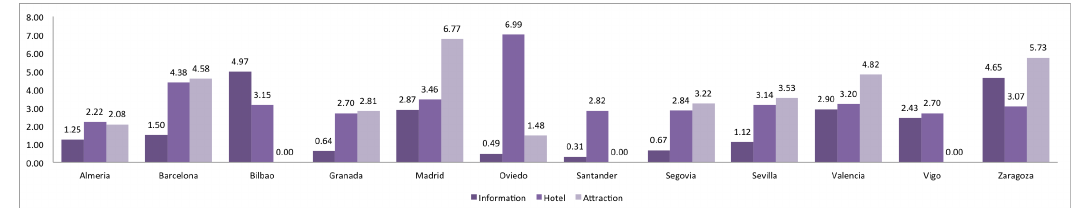
Figure 11. Consistency study of tourism in Spain. Standard deviation of tag